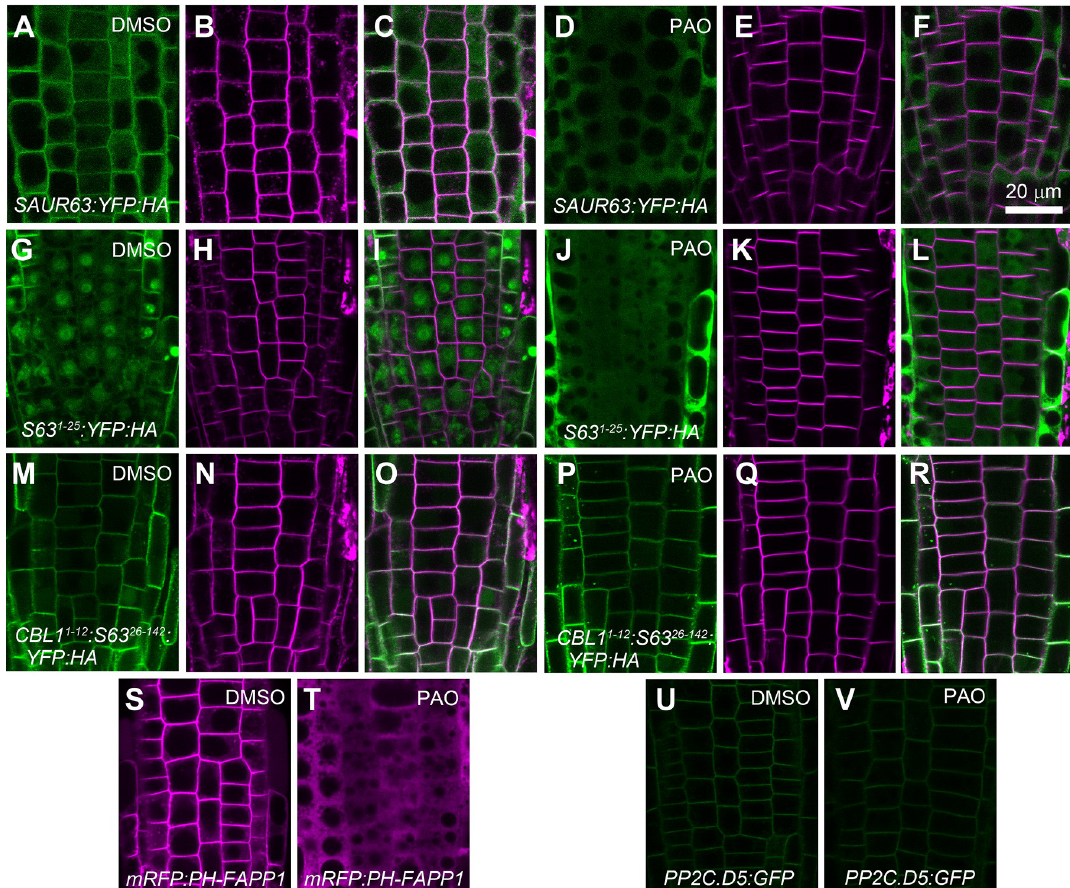
Fig 6. Effect of PAO treatment on plasma membrane localization of SAUR63:YFP fusion proteins. A-F) P G-L) P 35S : SAUR63 1-25 : YFP : HA . M-R) P 35S : CBL1 1-12 : SAUR63 26-142 : YFP : HA . S,T) P 35S : mRFP : PH-FAPP1 . U,V) P PP2C . D5 : PP2C . D5 : GFP . Roots were treated with DMSO (A-C,G-I,M-O,S,U) or the PI4K inhibitor PAO (D-F,J-L,P-R,T,V) for 30 minutes before imaging root meristem cells. Shown are YFP fluorescence (green, A,D,G,J,M,P), FM4-64 staining red fluorescence (magenta, B,E,H,K,N,Q), and both YFP and FM4-64 signals together (C,F,I,L,O,R). In S and T, magenta fluorescence shows the mRFP:PH-FAPP1 control PI(4)P- binding fusion protein. In U and V, green fluorescence shows the PP2C.D5:GFP protein. Scale bar, 20 μ m.